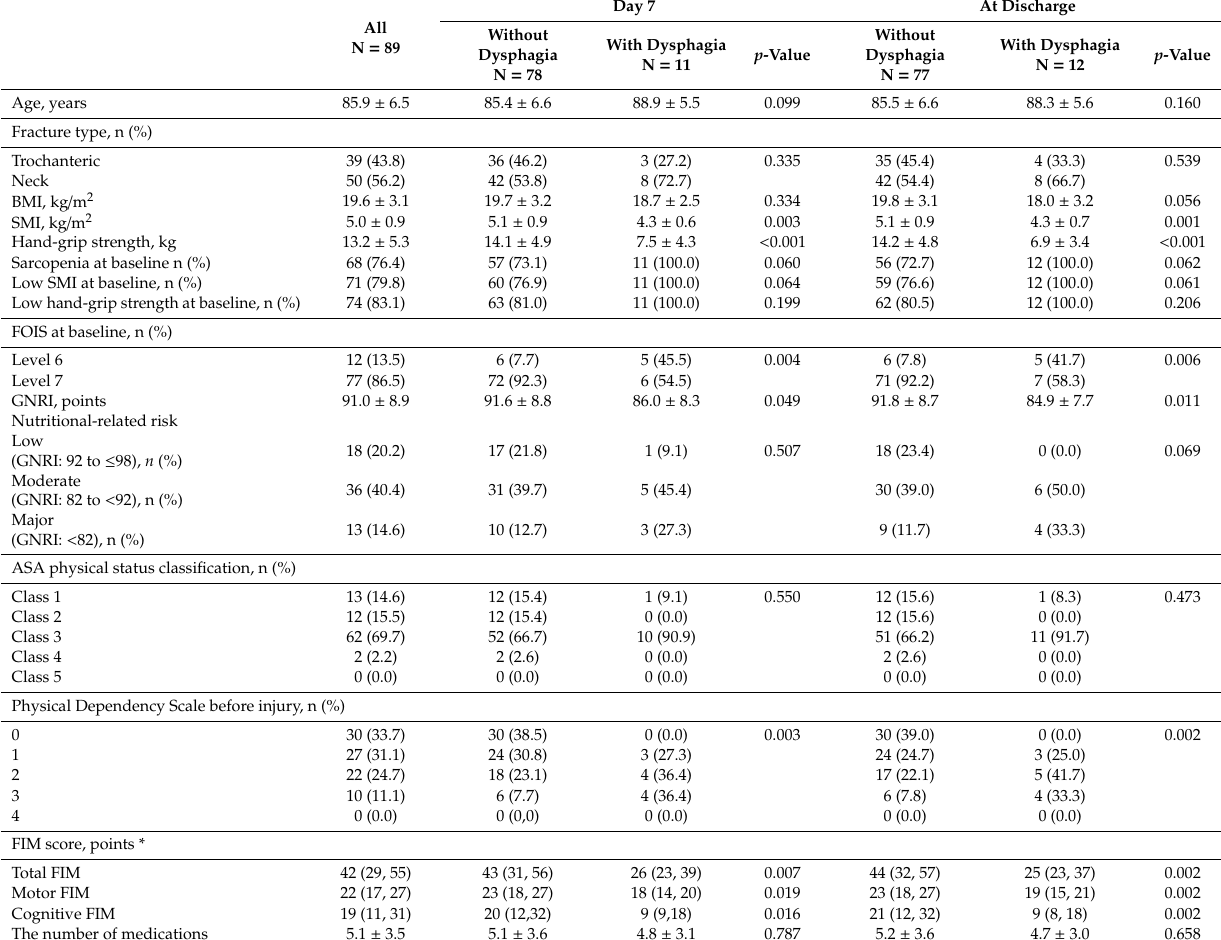
Table 1. The baseline characteristics of patients in the study